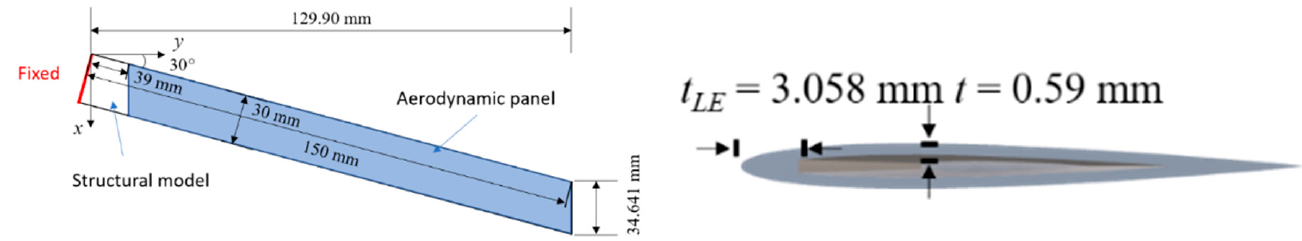
Figure 6. Planform ( left ) and cross section at root ( right ) of the flutter wing model.